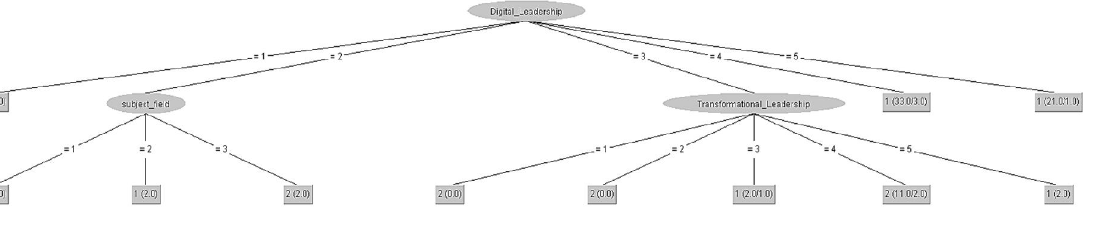
Figure 9. Decision Tree 1.